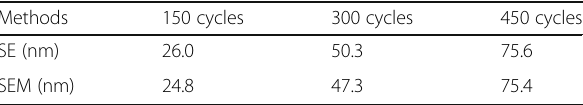
Table 1 Thickness of AZO films simulated by SE and measured by SEM, respectively